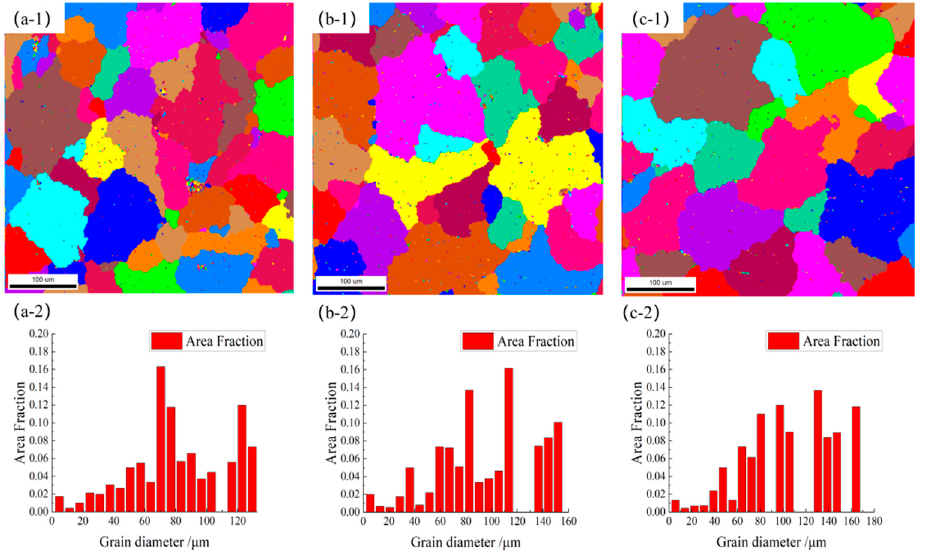
Figure 9. EBSD results near WM: (( a-1 ),( a-2 )) 90 A; (( b-1 ),( b-2 )) 105 A; (( c-1 ),( c-2 )) 120 A. The EBSD images near the fusion line of different welding current are shown in Figure 10. Figure 10((a-1)–(c-1)) present EBSD images near the fusion line for 90 A, 105 A and 120 A current. The grain shapes are equiaxed crystals and columnar crystals. The maximum grain size is greater than 90 μ m when the welding current is 90 A, and the result is displayed in Figure 10(a-2). As shown in Figure 10(b-2), when the welding current is 105 A, the maximum grain size is greater than 110 μ m. When the welding current is 120 A in Figure 10(c-2), the maximum grain size is greater than 90 μ m.